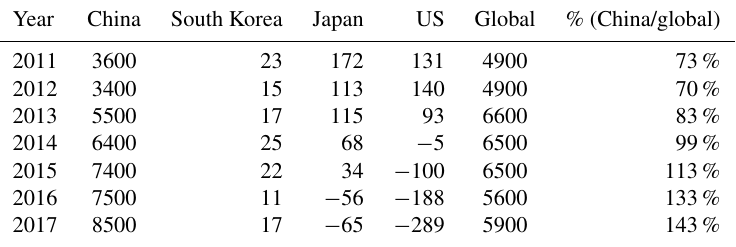
Table 5. Like Table 4 but for ozone-related mortality burden